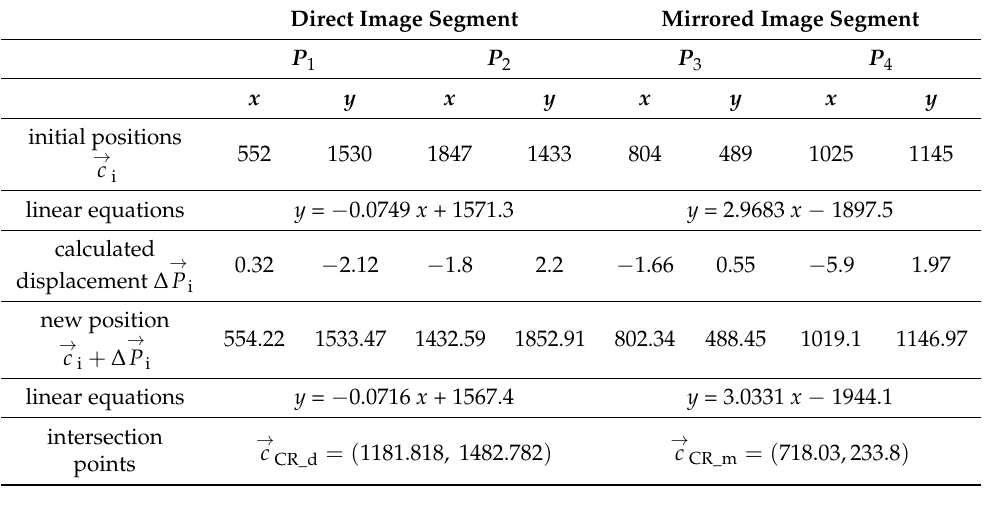
Table 1. Determination of the centers of rotation in both image segments.